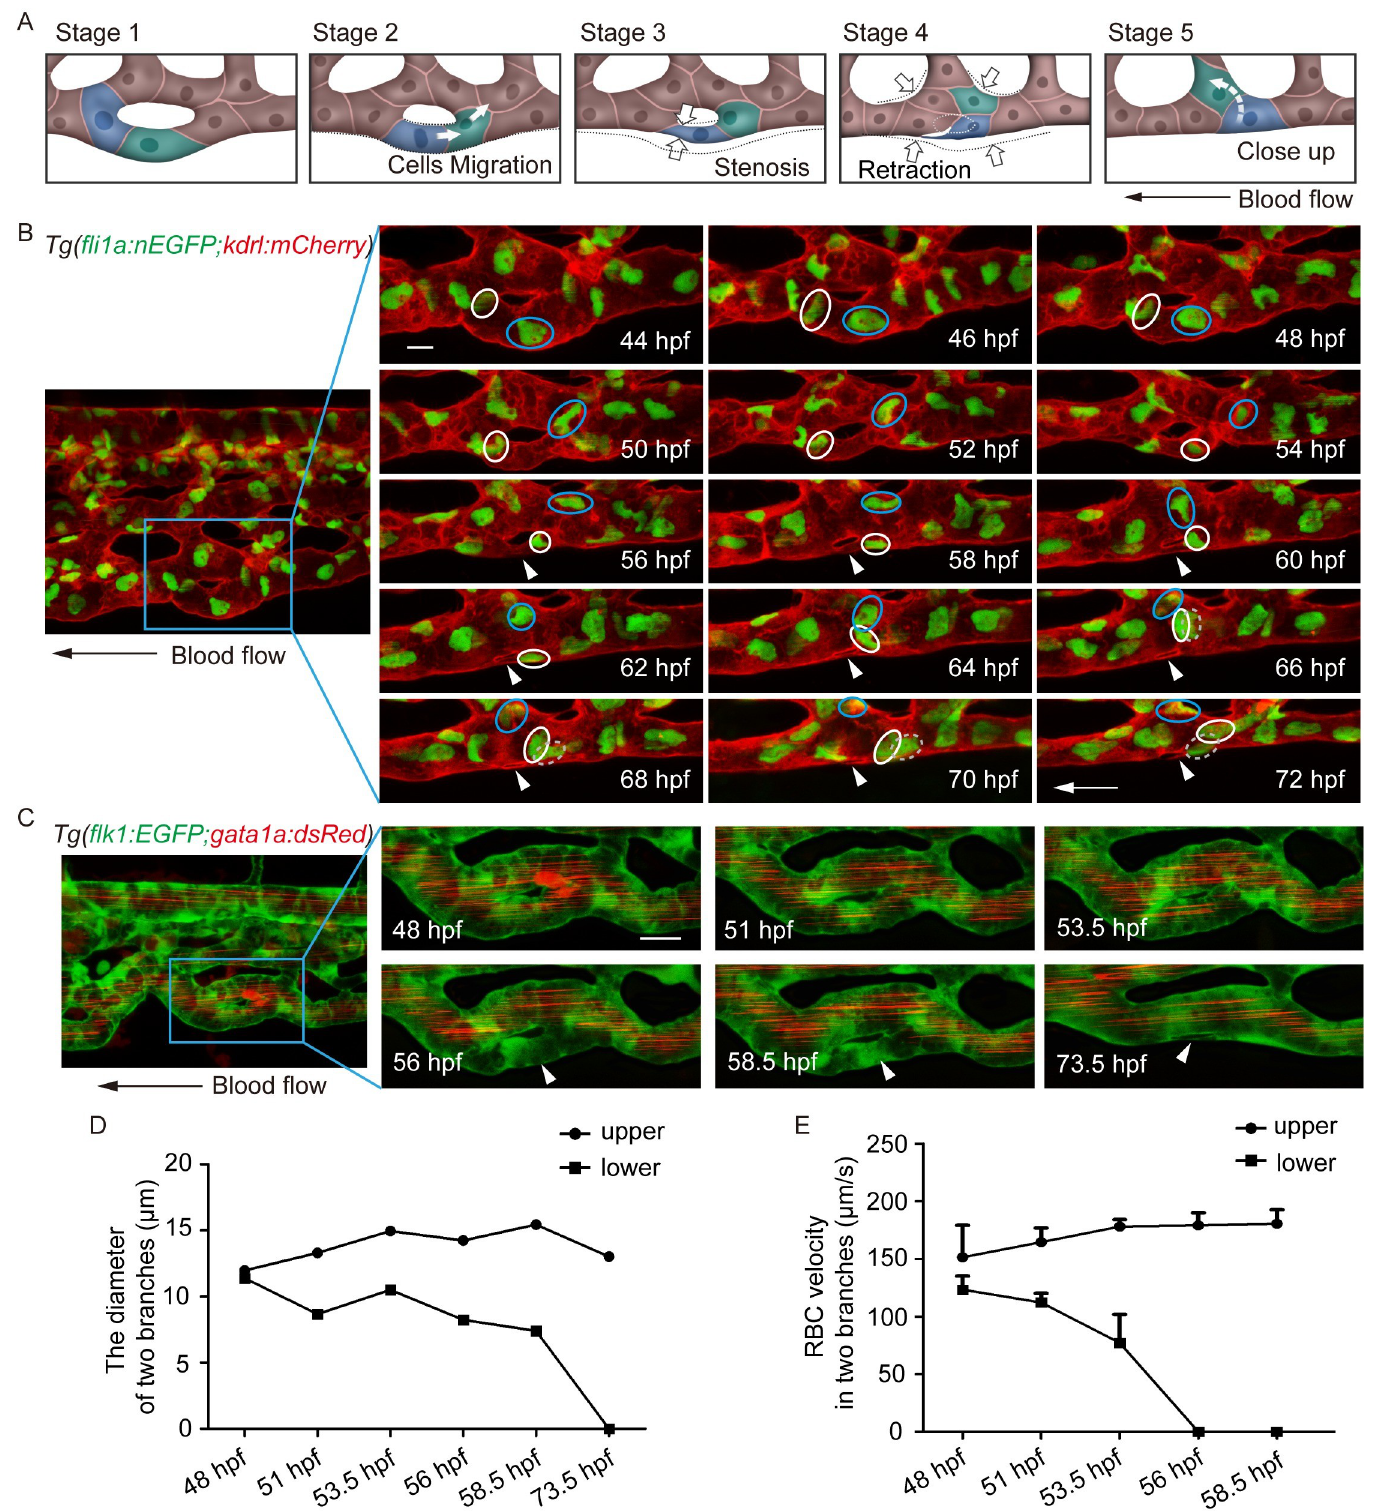
Fig 2. Endothelial cell behavior and the growing difference in blood flow between two branches in vessel pruning. (A) Sketch map of EC rearrangement during vessel pruning. (B) Time-lapse live imaging of Tg(fli1a : nEGFP;kdrl : mCherry) embryos shows EC nucleus migration in CV pruning. Arrowheads indicate the pruned vessel. The